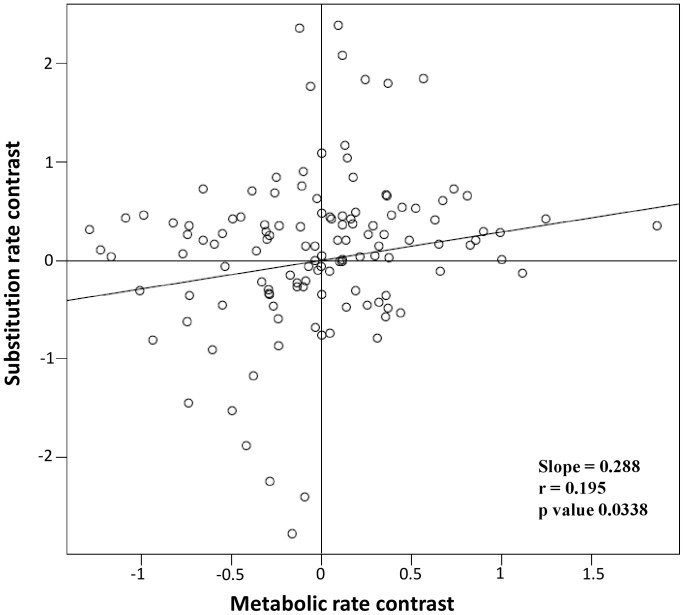
Plots of phylogenetically independent sister pair comparisons of substitution rate against mass specific metabolic rate.The X values correspond to the natural logarithm of the mass specific metabolic rate of the first species divided by the mass specific metabolic rate of the second species. The Y values correspond to the natural logarithm of the branch length of the first species divided by the branch length of the second species. Regression line was forced through the origin.